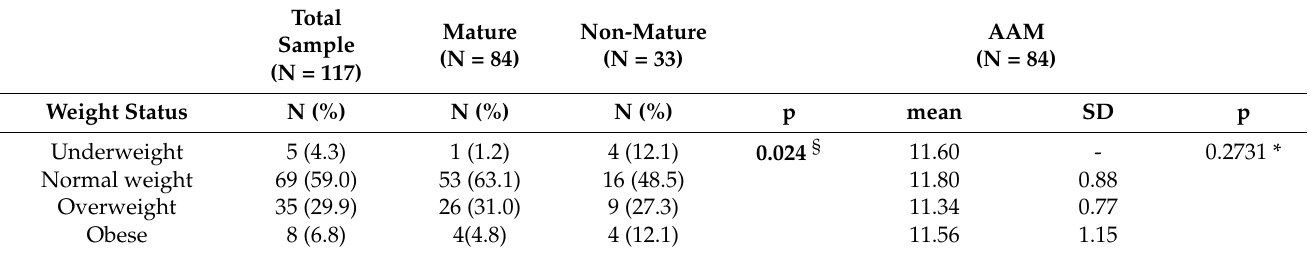
Table 2. Distribution and age at menarche (AAM) of the sample by weight status